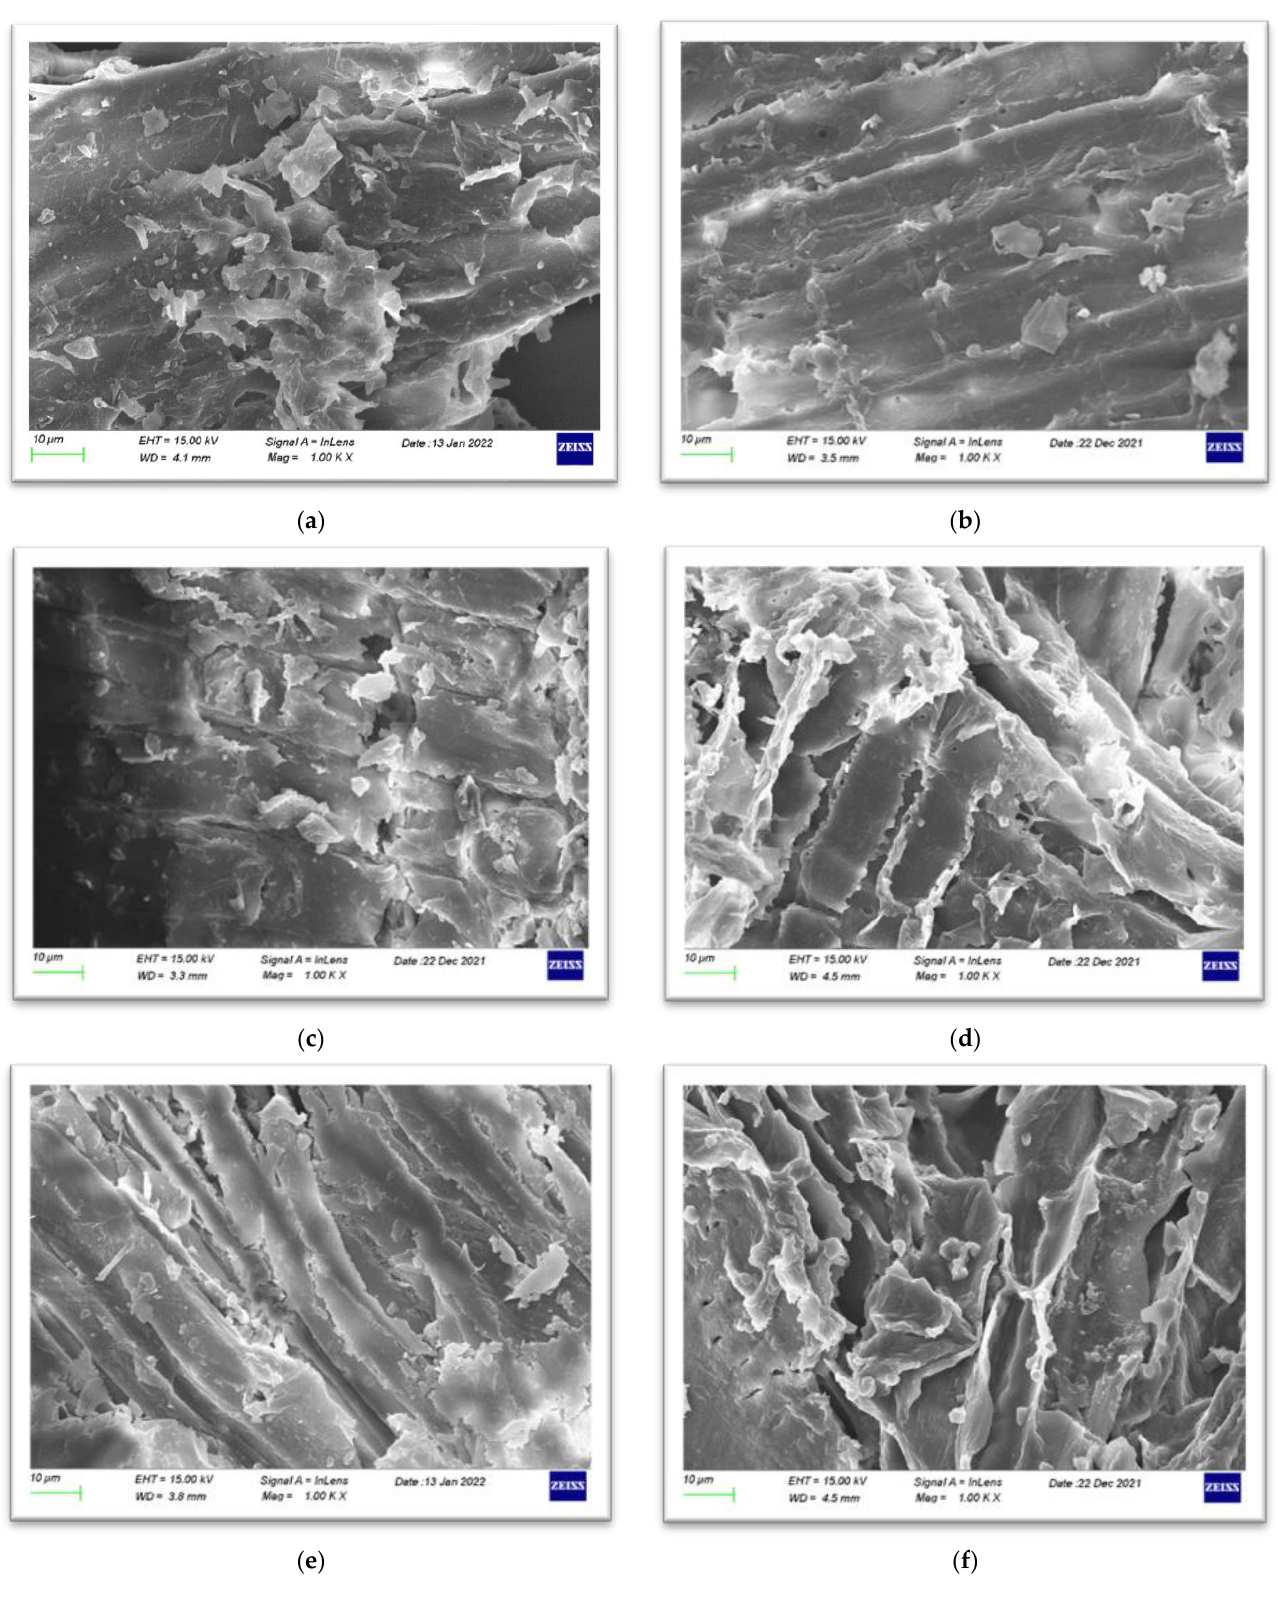
Figure 4. SEM images of ( a ) raw WS and WS after pretreatment with ( b ) (A) NaOH (0.5% w / v ), ( c ) (B) H 2 O 2 (0.5% v / v ), ( d ) (C) mixture of NaOH (0.5% w / v ) and H 2 O 2 (0.5% v / v ) at ratio 1:1, ( e ) (D) initially NaOH (0.5% w / v ) followed by H 2 O 2 (0.5% v / v ), and ( f ) (E) initially H 2 O 2 (0.5% v / v ) followed by NaOH (0.5% w / v ).